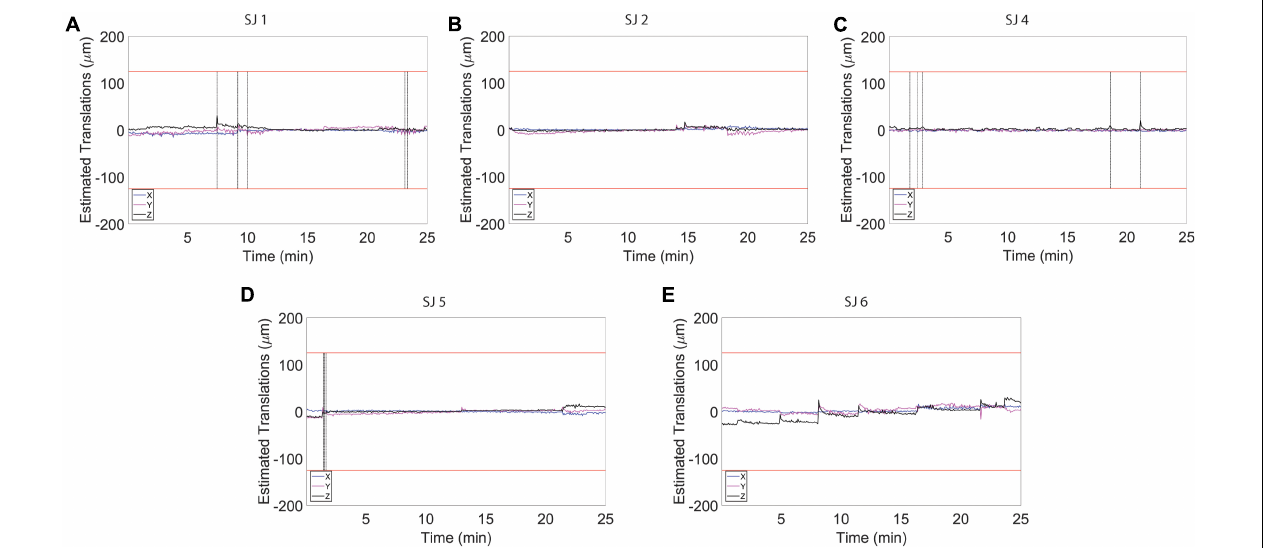
FIGURE 6 | Estimated motion levels for individual animals during auditory functional magnetic resonance imaging (fMRI) acquisition. (A–E) Estimated motion levels (translations) for five individual animals during auditory fMRI acquisition. Motion levels during the auditory task are lower and more stable compared to the levels detected during the resting state acquisitions ( Figure 4 ). The red lines represent 1/4 of the voxel size. The vertical black line indicates the location of a spike in the time course that was removed using the Matlab toolbox, ArtRepair.